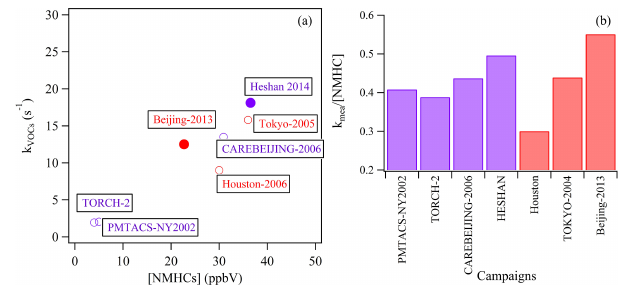
Figure 10. (a) Comparison of VOC reactivity and measured NMHCs in urban and suburban observations. (b) Comparison of the ratio between VOC reactivity and measured NMHCs in urban and suburban